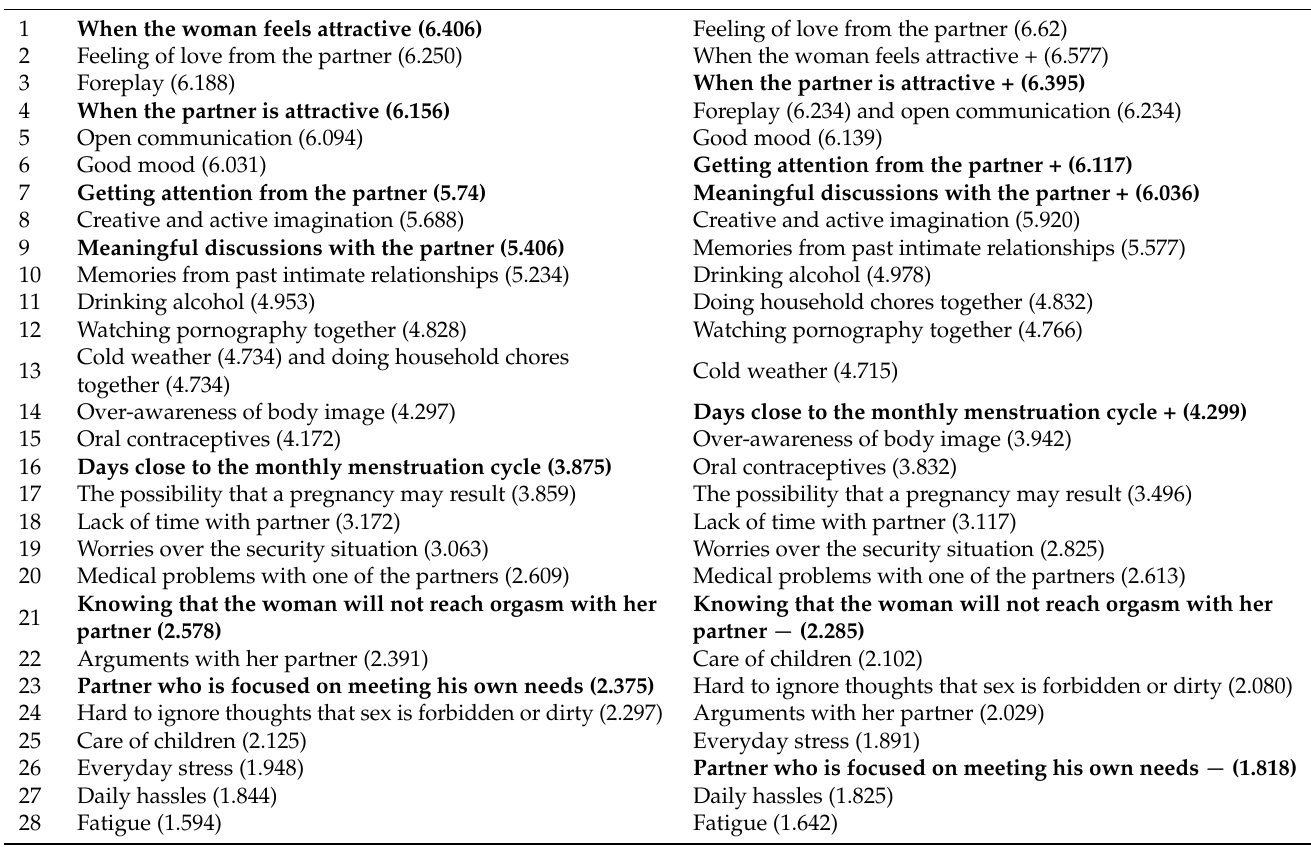
Table A1. Mean values of the variables that affect women’s sexual desire rated by men and